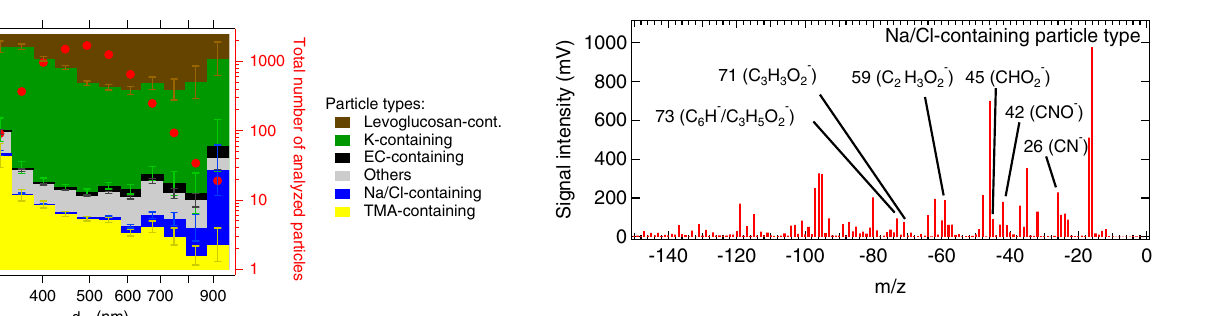
Figure 7. Expanded mean anion spectrum of 106 (1%) Na / Cl- containing single particle spectra from Fig. 4b. Only the organics peaks are highlighted